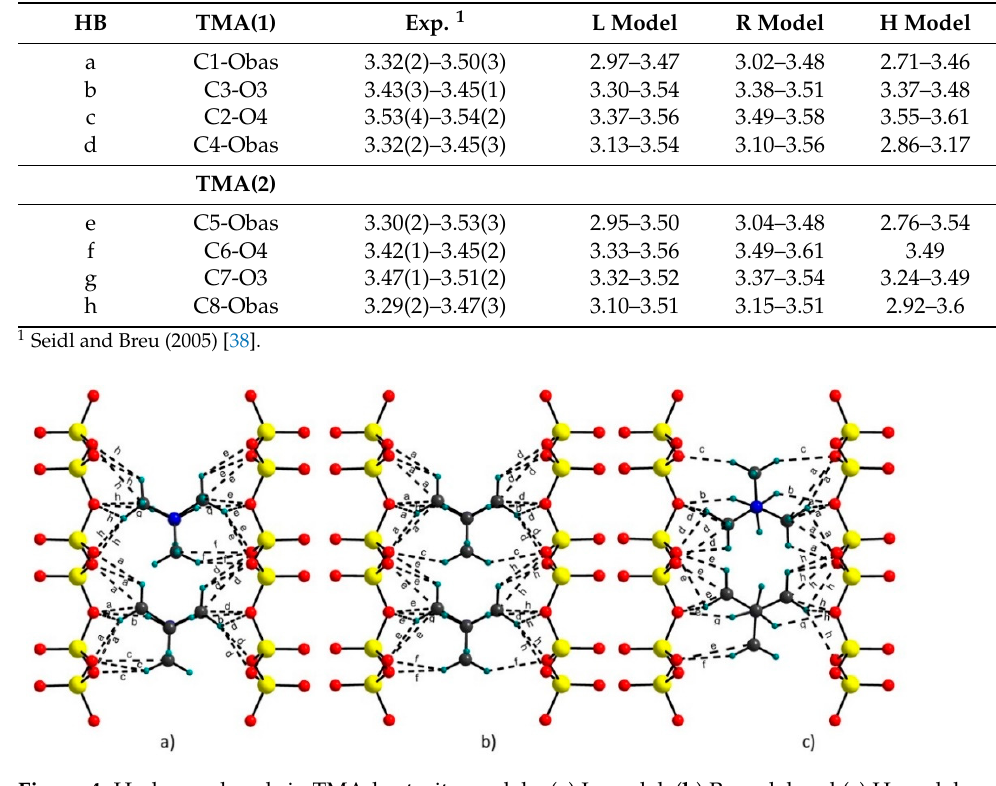
Figure 4 . Hydrogen bonds in TMA-hectorite models: ( a ) L model; ( b ) R model and ( c ) H model.